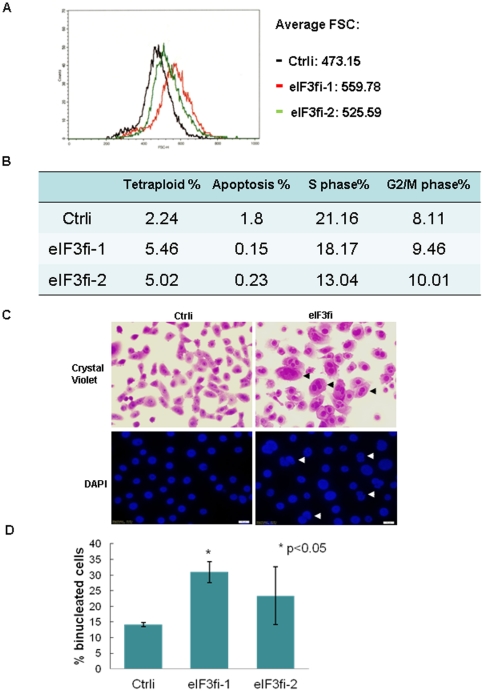
eIF3f-silencing led to increased cell size, nuclear pleomorphism, aneuploidy, and cell cycle abnormality.(A) eIF3f-silenced cells had an increased cell size. Two proliferating eIF3f-silenced clones (#4 and #5) and a control RNAi HPDE cell line were harvested and resuspended at 1×106/ml in PBS solution. Cell sizes (indicated by forward scatter wave length-FSC) were measured by flow cytometry. (B) eIF3f-silenced cells had increased tetraploidy, increased number of G2/M phase cells, and decreased apoptosis. Cell cycle and apoptosis (indicated by sub-G1 peak) of 2 different eIF3f-silenced clones and a control RNAi HPDE cell line were measured by propion iodine staining and flow cytometry. Percentages of the indicated cells out of total cells were listed. (C) eIF3f-silencing produced increased binucleated/multinucleated cells (arrows). eIF3f-silenced cells and control HPDE cells were stained by crystal violet or DAPI. Representative images were shown. (D) Binucleated cells were counted in 2 different eIF3f-silenced clones and a control cell line. Average percentage of binucleated cells out of total cells from 3 independent experiments was shown.